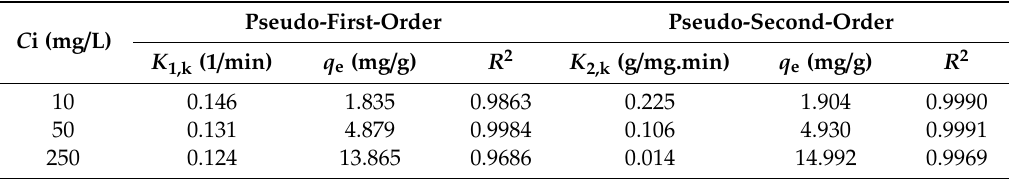
Table 3. Parameters of adsorption kinetics of ciprofloxacin (CFX) onto PMA. C i (mg /